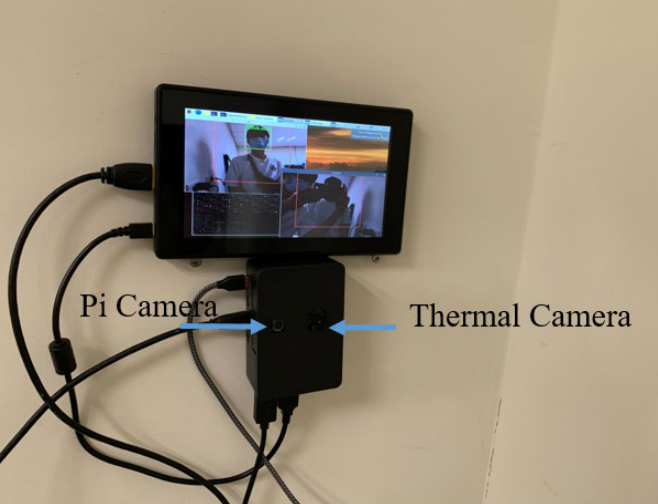
Figure 7. Embedded system settings, including Pi camera for video data input and thermal camera for temperature information input.